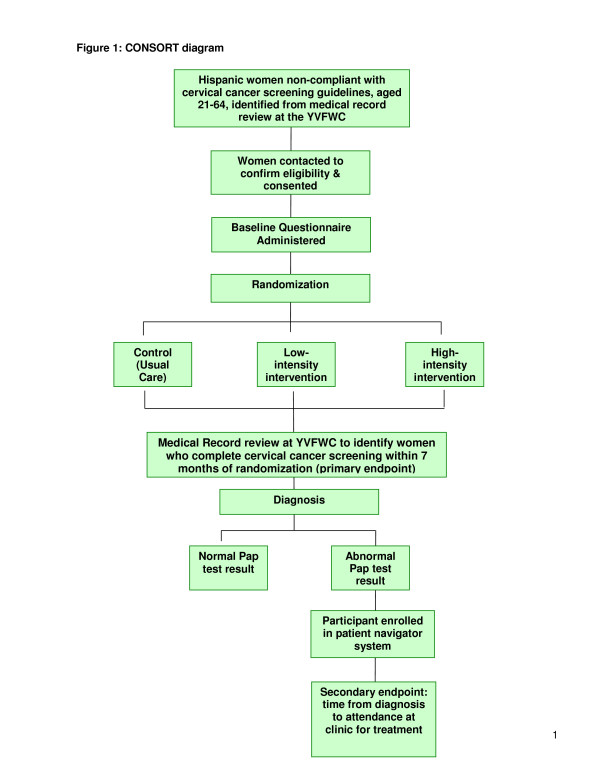
CONSORT diagram.